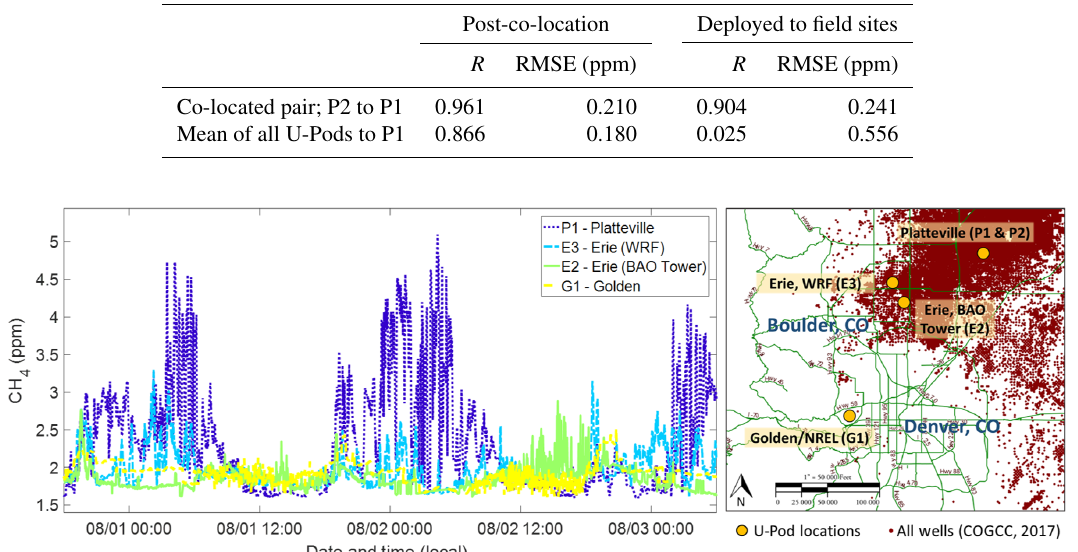
Table 8. Statistics for Colorado data converted using the universal model method.